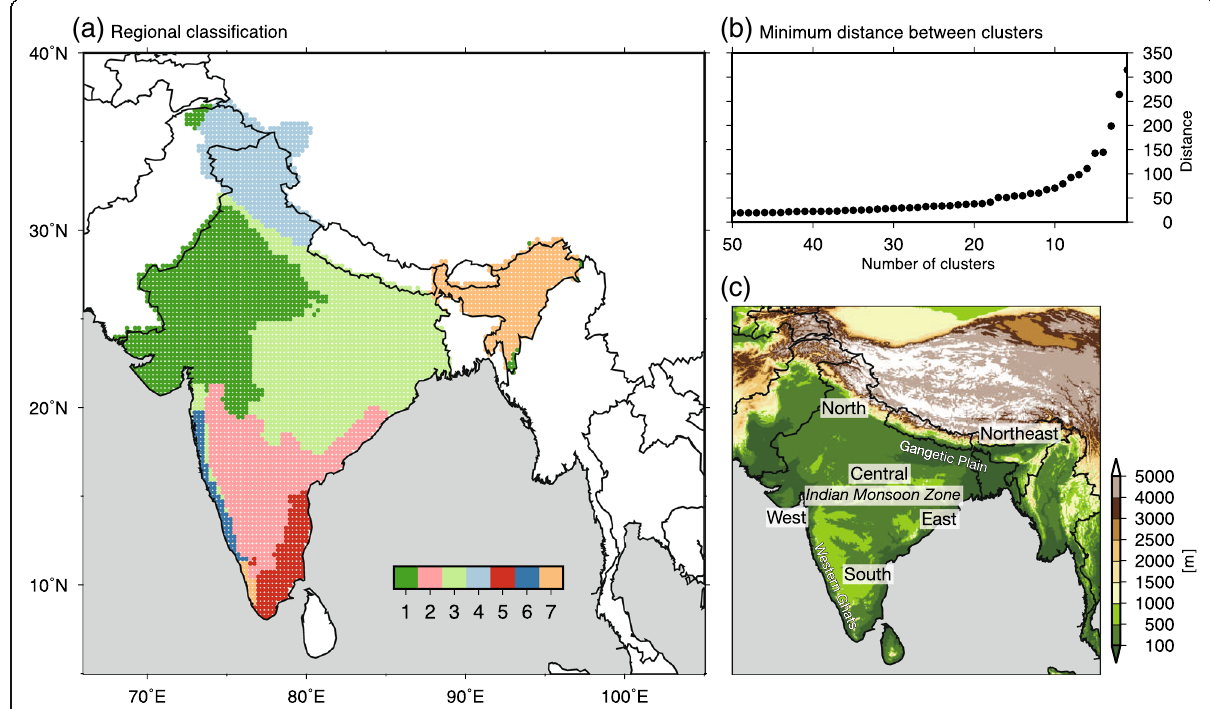
Fig. 2 Results and process of cluster analysis. Distribution of regional classification based on the seasonality of averaged pentad precipitation for 1901 – 2013 ( a ), the process of clustering (only shows the number of clusters below 50) ( b ), and a map of the study area ( c